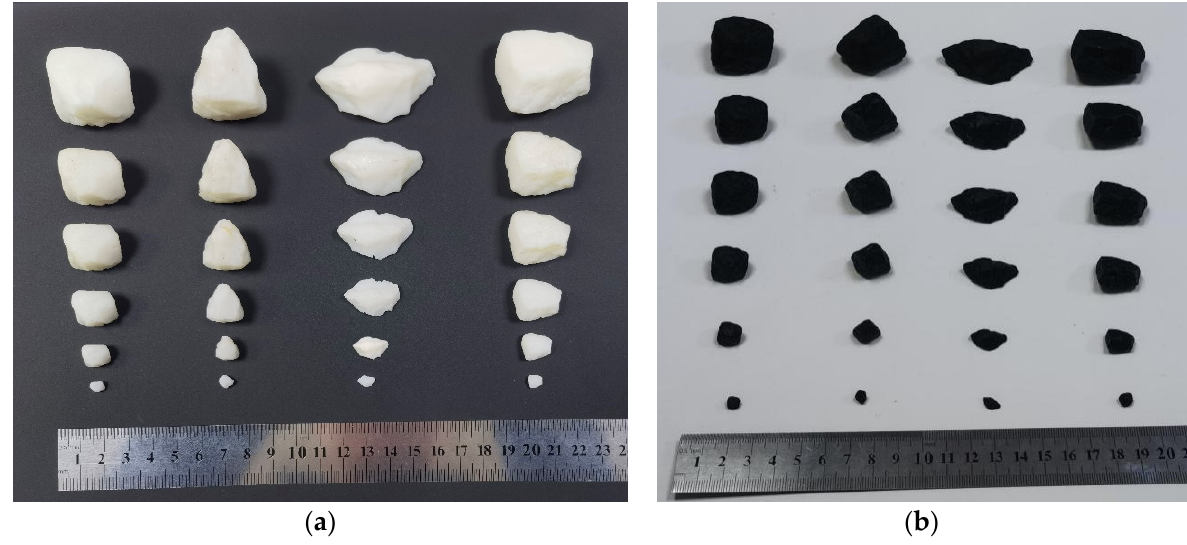
Figure 6. 3D printing resign-based models ( a ): photosensitive resin; ( b ): ABS resign model.